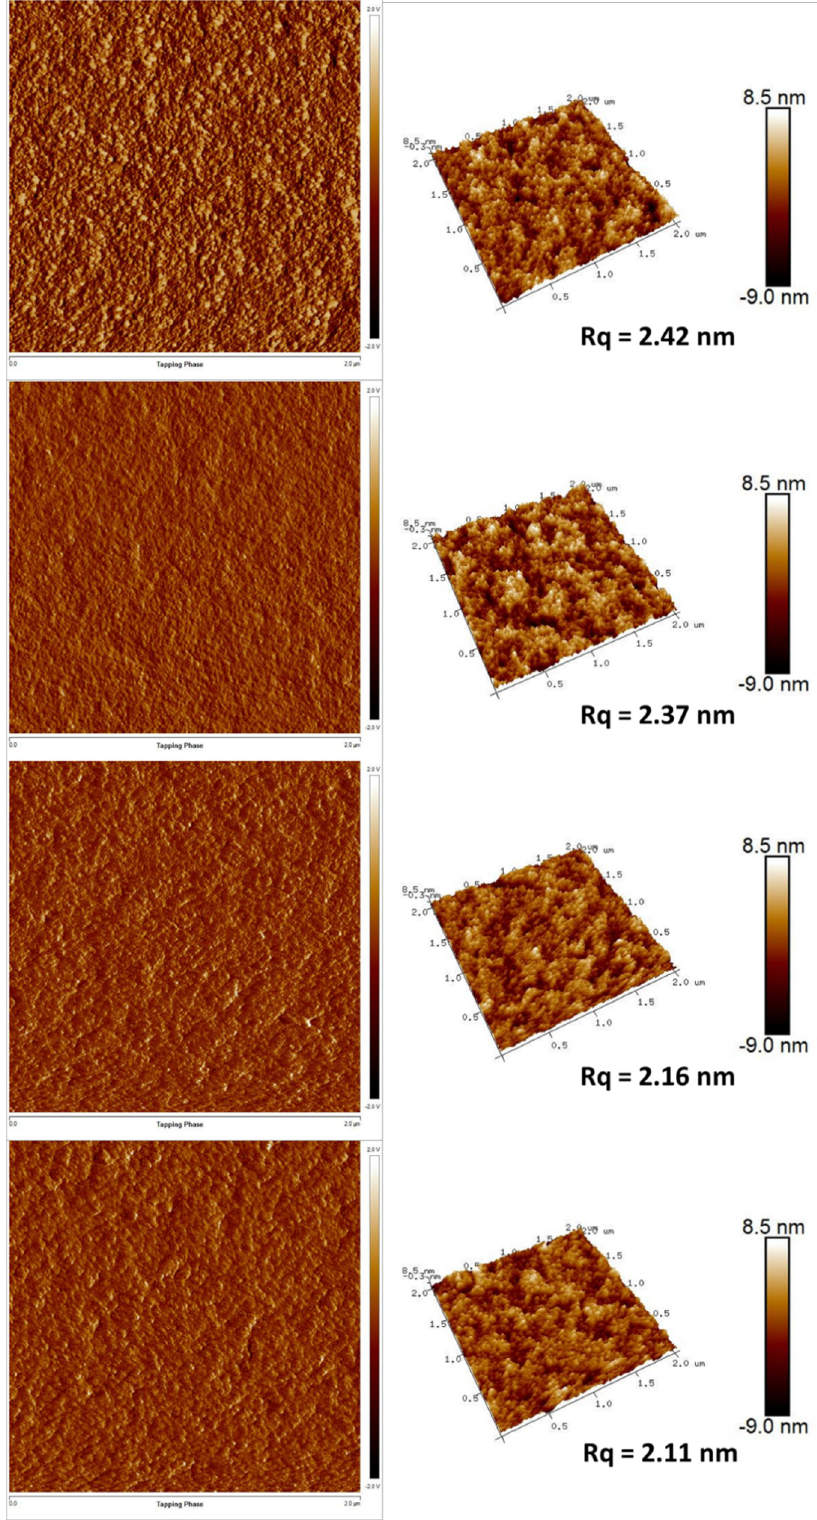
Figure 5. AFM phase ( left ) and topography ( right ) images for VB-FNPD films prepared by different standing times (top to bottom: W/O standing, 20, 40 and 60 min).